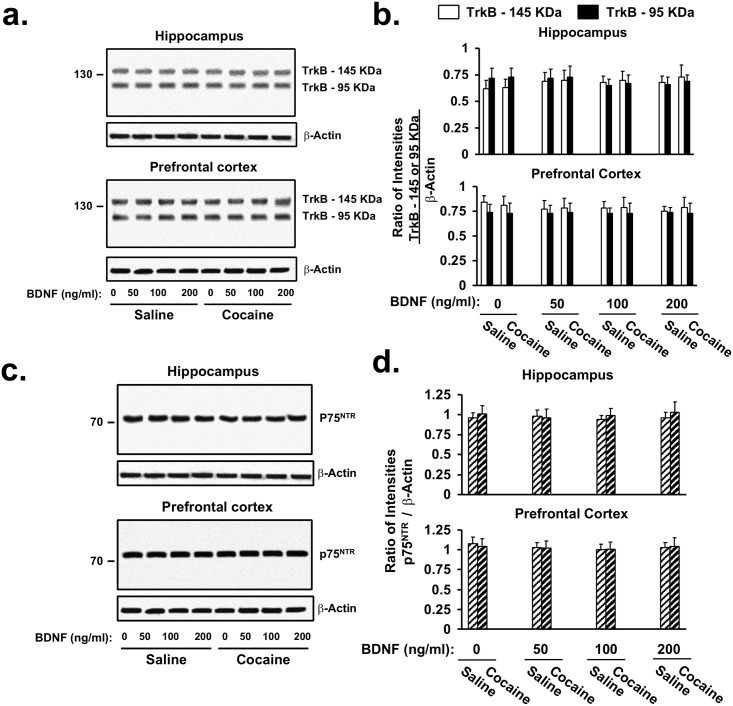
Ex vivo exposure to 50–200 ng/ml BDNF did not alter the expression of full-length (145-KDa) and truncated (95-KDa) TrkB and p75NTR in BDNF-incubated hippocampal and prefrontal cortical slices.The abundance of 145- and 95-KDa TrkB (a, b) as well as p75NTR (c, d) in 50 μg post-mitochondrial synaptosome-enriched fractions prepared from hippocampal and PFCX slices of P21 prenatal cocaine- and saline-exposed rats following 30-min incubation with 50–200 ng/ml BDNF were compared by Western blotting. The blots were stripped and re-probed with anti-β-actin to validate equal loading. Densitometric quantification of blots revealed no discernible differences in 145- and 95-KDa TrkB as well as p75NTR expression levels as a result of incubation with BDNF. n = 4. Data are mean ± s.e.m. of the ratio of 145-, 95-KDa TrkB, p75NTR to β-actin optical intensities.